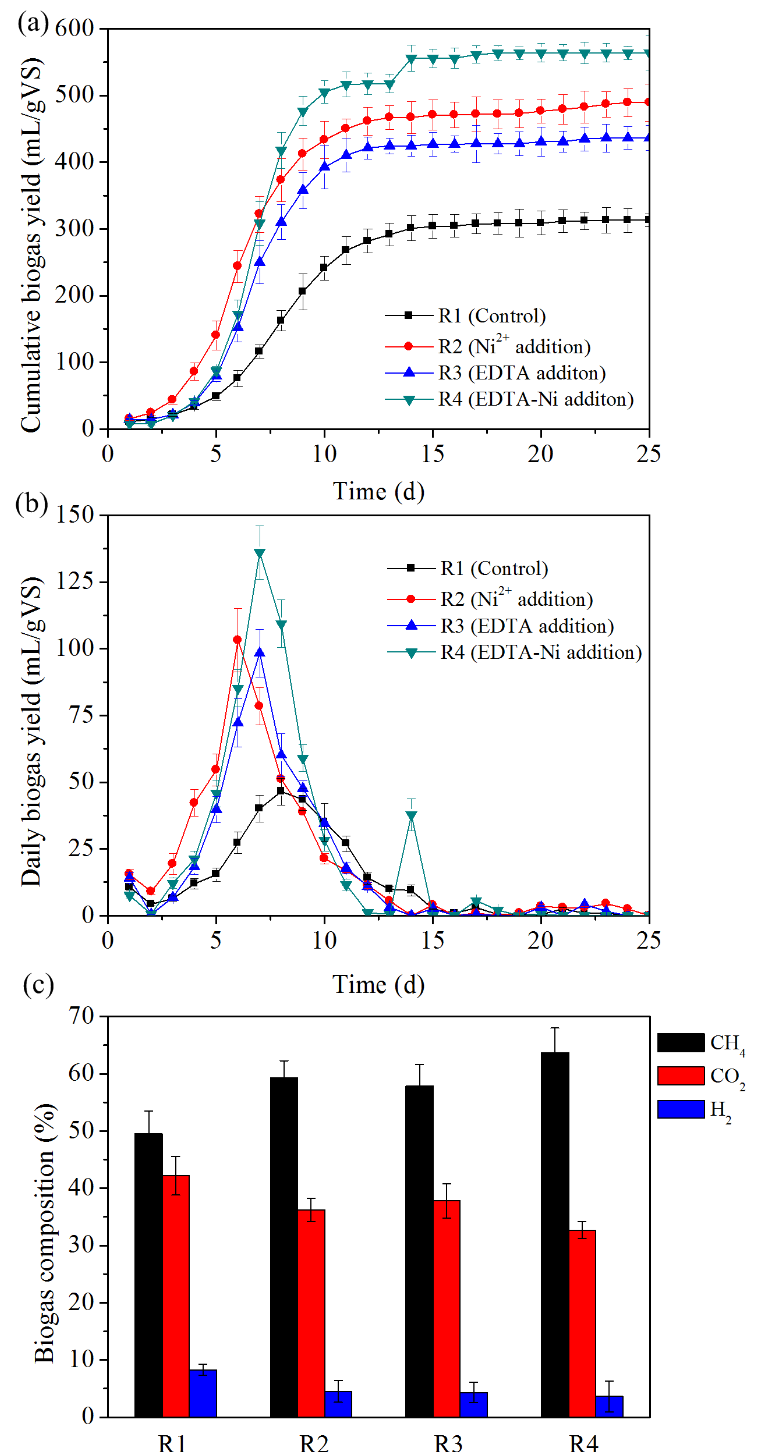
Figure 1. Effect of ethylenediaminetetraacetic acid (EDTA) and/or Ni on ( a ) cumulative biogas production and ( b ) daily biogas yield, and ( c ) biogas composition in the AD of KWs.